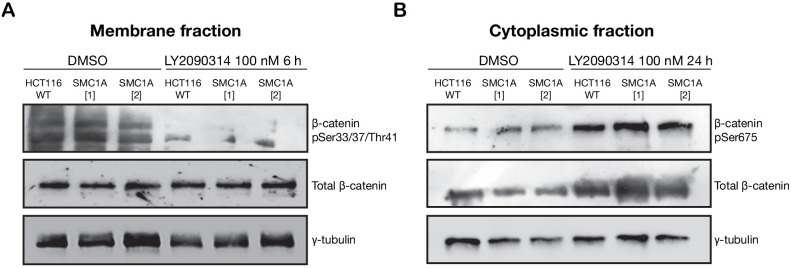
LY2090314-mediated WNT stimulation leads to increased β-catenin stabilization in SMC1A mutant HCT116 cells.Unmodified HCT116 cells (WT), and cells modified to contain SMC1A mutations: SMC1A (1), c.2027A > G; SMC1A (2), c.2479 C > T, were treated with DMSO or LY2090314 at 100 nM for 24 hr. (A) Immunoblot of the membrane fraction of HCT116 wild type (WT) and SMC1A mutant-expressing HCT116 cells. The proteasome-targeted form of β-catenin phosphorylated at Ser33/37/Thr41 is slightly less abundant in the SMC1A mutants, and this phospho isoform is degraded in all cells following treatment with LY2090314. (B) Immunoblot of the cytoplasmic fraction shows increased basal level of phosphorylated β-catenin at Ser675 in the SMC1A mutant-expressing cells compared with HCT116 WT, and LY2090314 treatment markedly increased total β-catenin in the SMC1A mutants compared with HCT116 WT. Untrimmed blots and molecular size markers are available for A,B in Figure 5—source data 4.